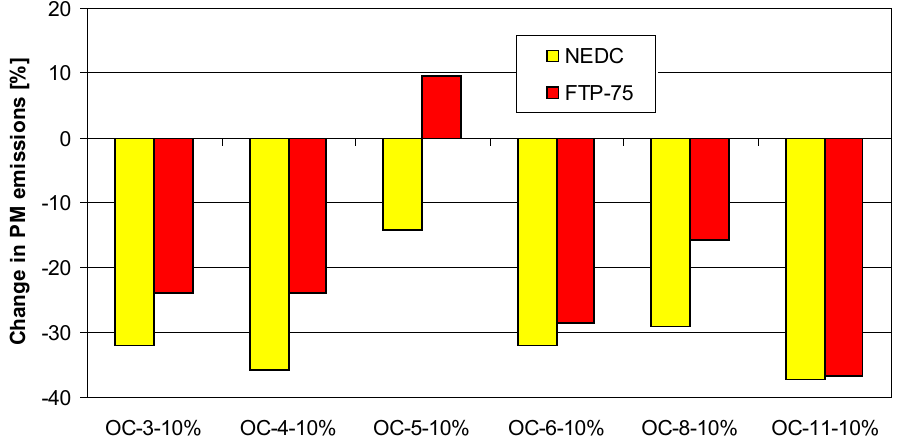
Figure 7. Percentage changes in PM emissions over the NEDC and FTP-75 cycles when the test car’s fuels contained 10% of various oxygenated compounds compared to running on conventional diesel fuel. The use of glycol ethers as fuel components for diesel engines also in studies presented by other authors led to a reduction in the emission of particulate matter (soot). In